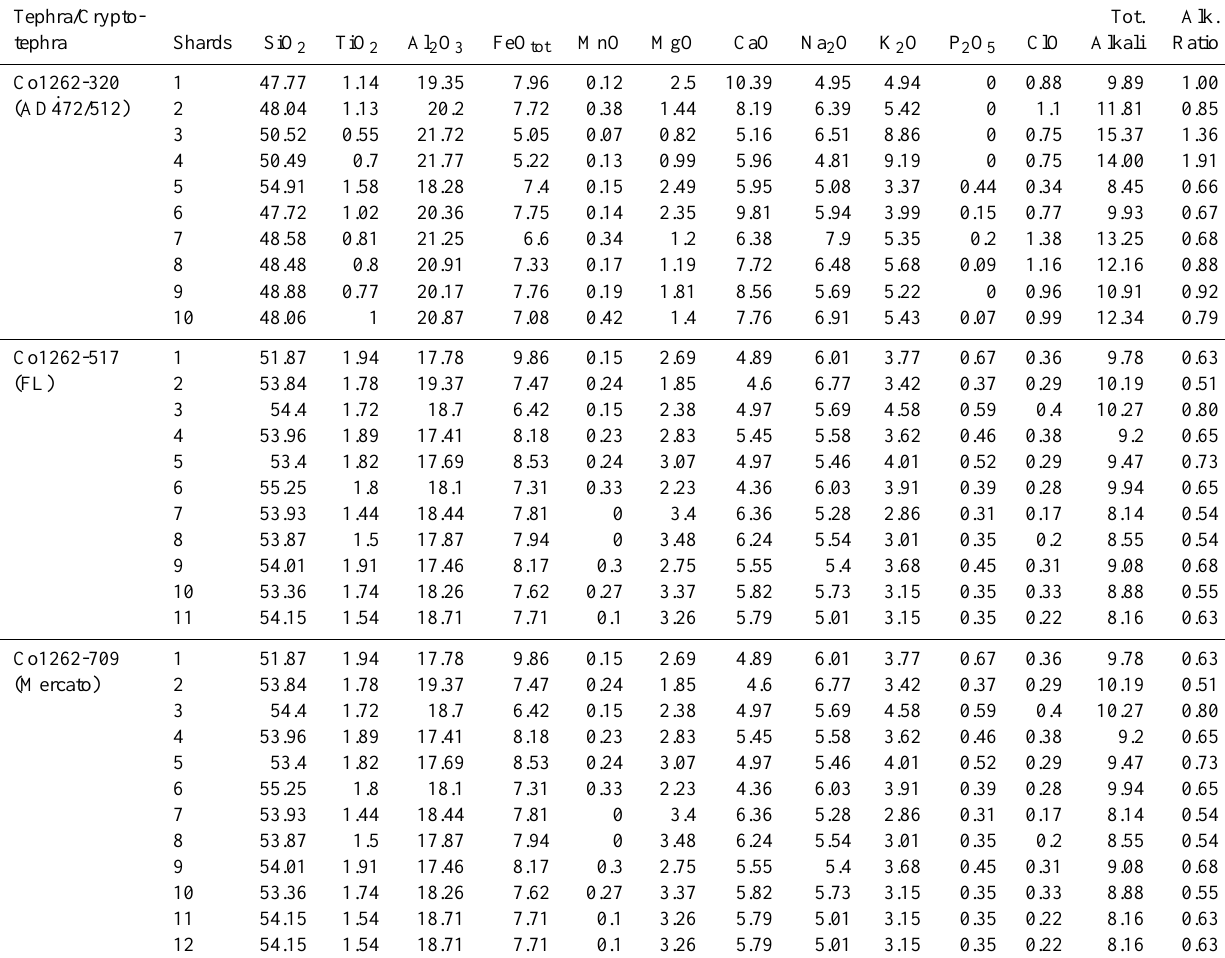
Table 2. Major element glass composition of tephras and cryptotephras in core Co1262. Tephra/Crypto- Tot.